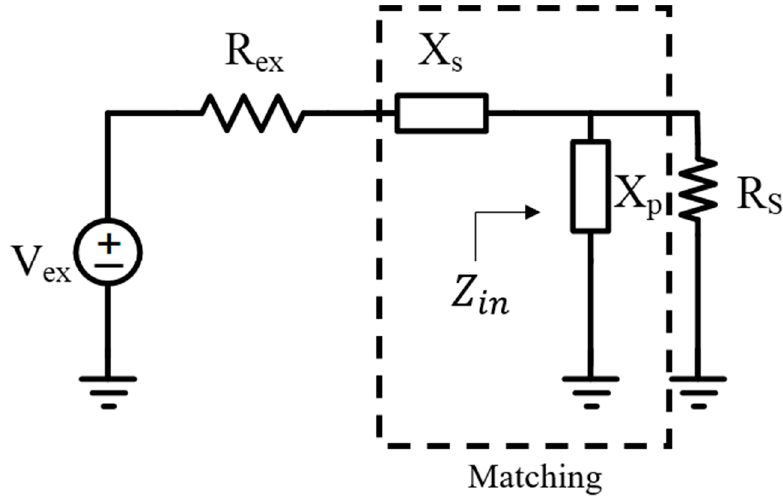
Figure 4. L-shaped section network for transducer.